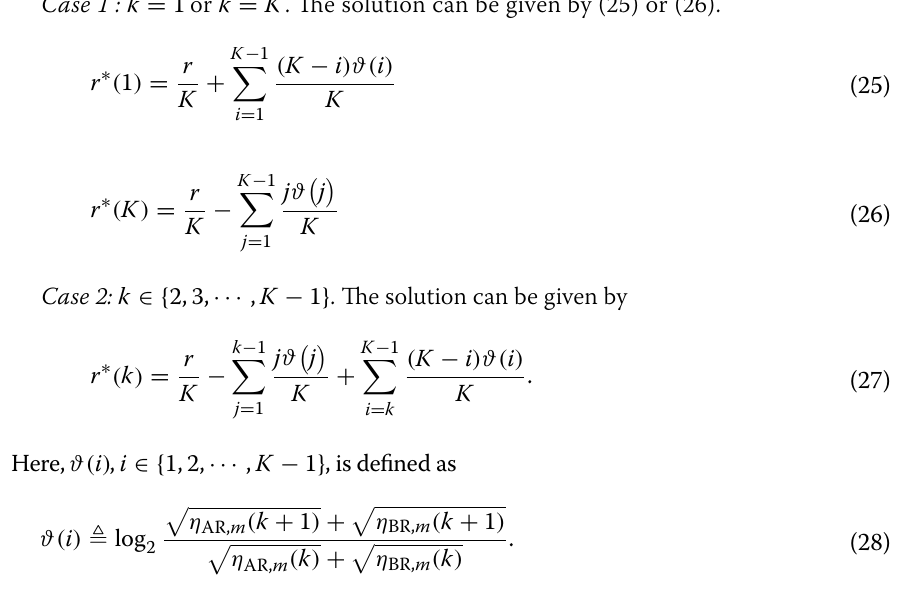
Algorithm 1. Optimal bit-rate